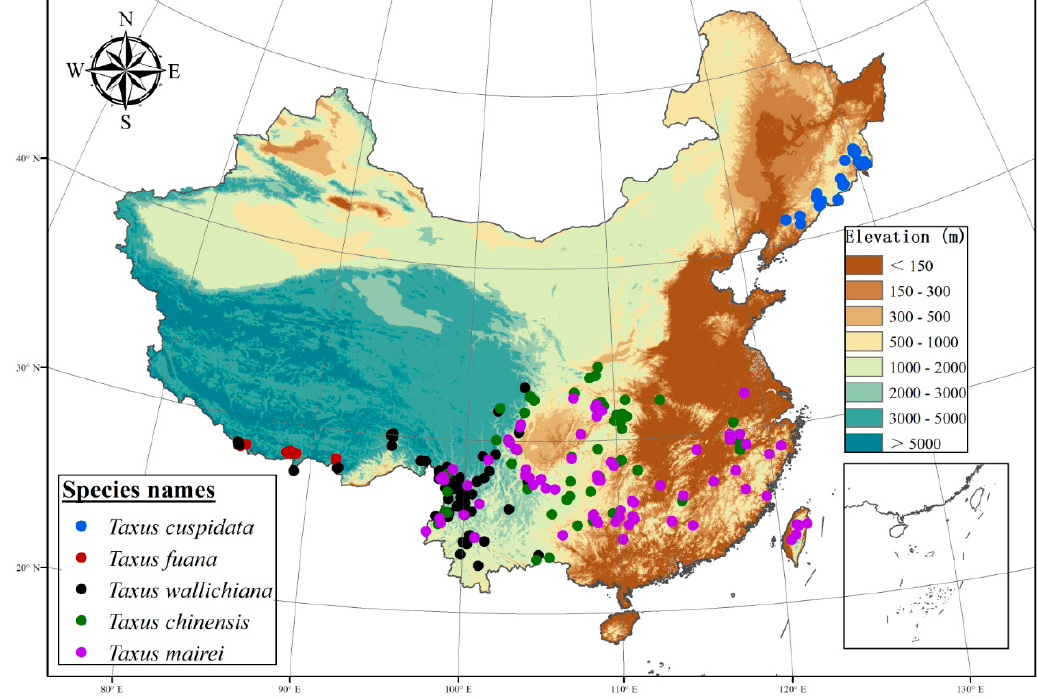
Figure 1. Locations of five Taxus species used in our study. Table 1. Conservation status of five Taxus species in the IUCN Red List and Threatened Species List of China’s Higher Plant, and number of each species occurrences.